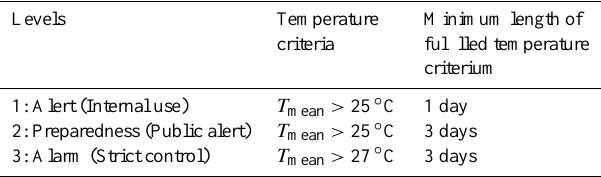
Table 1. Heat wave warning levels of HHWS applied in Hungary ( T mean indicates the daily mean temperature).